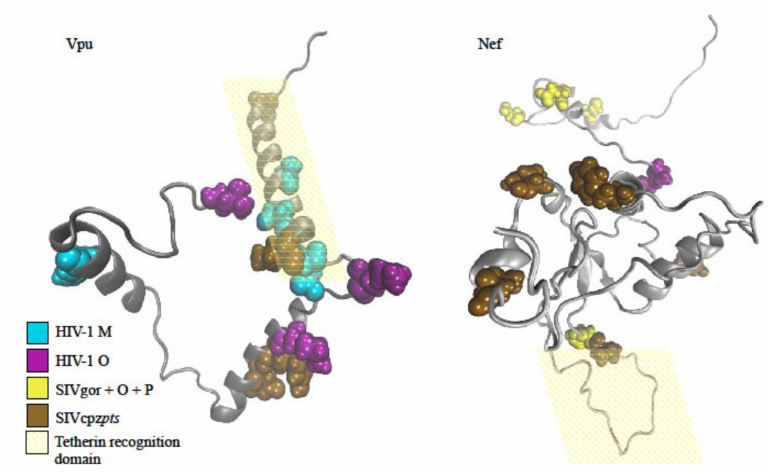
Figure 3. Projection of the identified rate decelerating sites for the prominent branches onto the structure of Vpu ( left , PDB ID: 2N28) and Nef ( right , obtained from